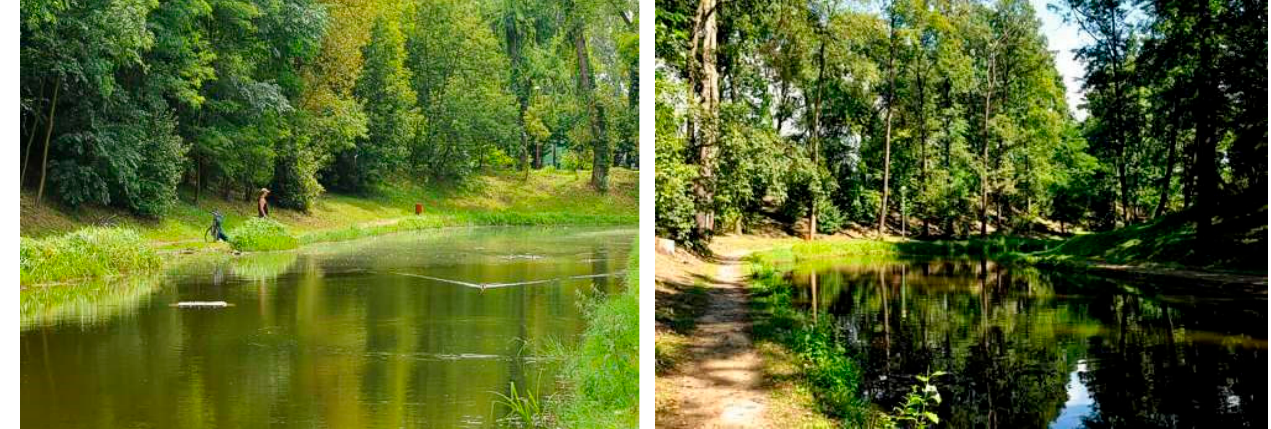
Figure 3. Fort Bema—Green and blue solutions to mitigate climate change in urban areas (Source: wazki.pl).